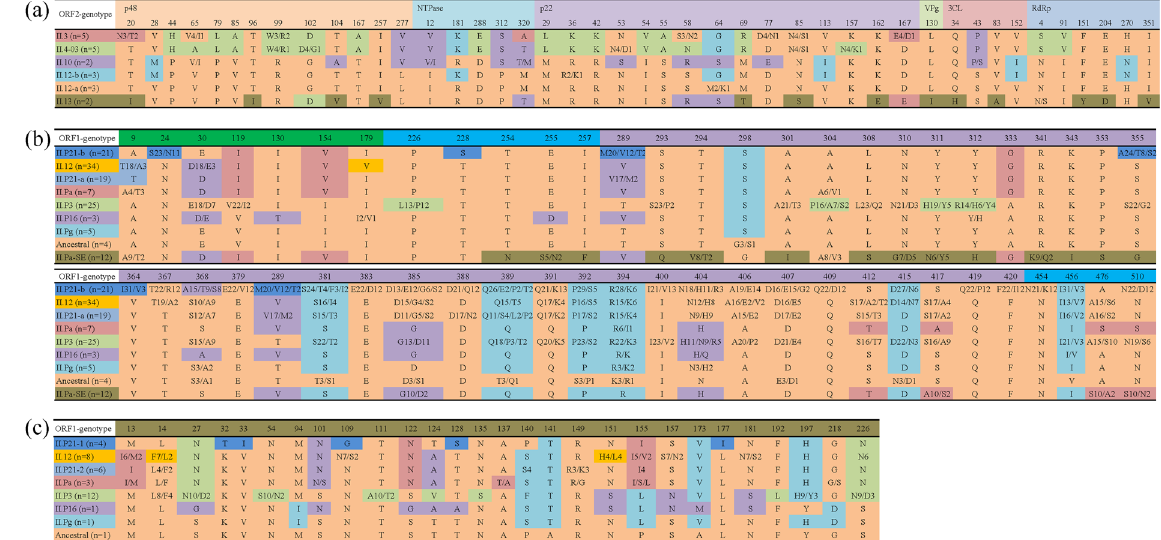
Figure 5. Informative sites of viral proteins among different clusters of ORF1-GII.P12 and ORF2-GII.3 recombinants based on multiple alignments. ( a ) For GII.P12 ORF1, different proteins (p48, NTPase, p22, VPg, 3C-Pro, and RdRp) are presented in light orange, light aqua green, light purple, light green, light pink, and light blue. Amino acids in ORF2-II.12-a cluster are colored in orange, and new amino acids used in other clusters (II.12-b, II.10, II.4-03, II.3, and II.13) were highlighted in aqua green, purple, green, pink, and tawny, respectively. ( b ) For GII.3 ORF2, the N- and C-terminal flanking regions of heterogeneity are in green for the S domain and cyan for the P1 subregion above the amino acids, and sites in P2 subregion are highlighted in light purple. Amino acids in ORF1-ancestral cluster are colored in orange, and new amino acids used in other clusters (II.Pg, II.P16, II.P3, II.Pa, II.P21-a, II.P12, II.P21-b, and II.Pa-SE) are highlighted in aqua green, purple, green, pink, light blue, orange, dark blue, and tawny, respectively. ( c ) For GII.3 ORF3, amino acids in ORF1- ancestral cluster are colored in orange, and new amino acids used in other clusters (II.Pg, II.P16, II.P3, II.Pa, II.P21-a, II.P12, and II.P21-b) are highlighted in aqua green, purple, green, pink, light blue, orange, and dark blue, respectively.